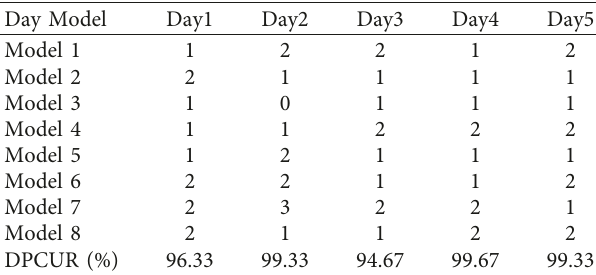
Table 3: Random order sequence of prefabricated walls of pro- duction period